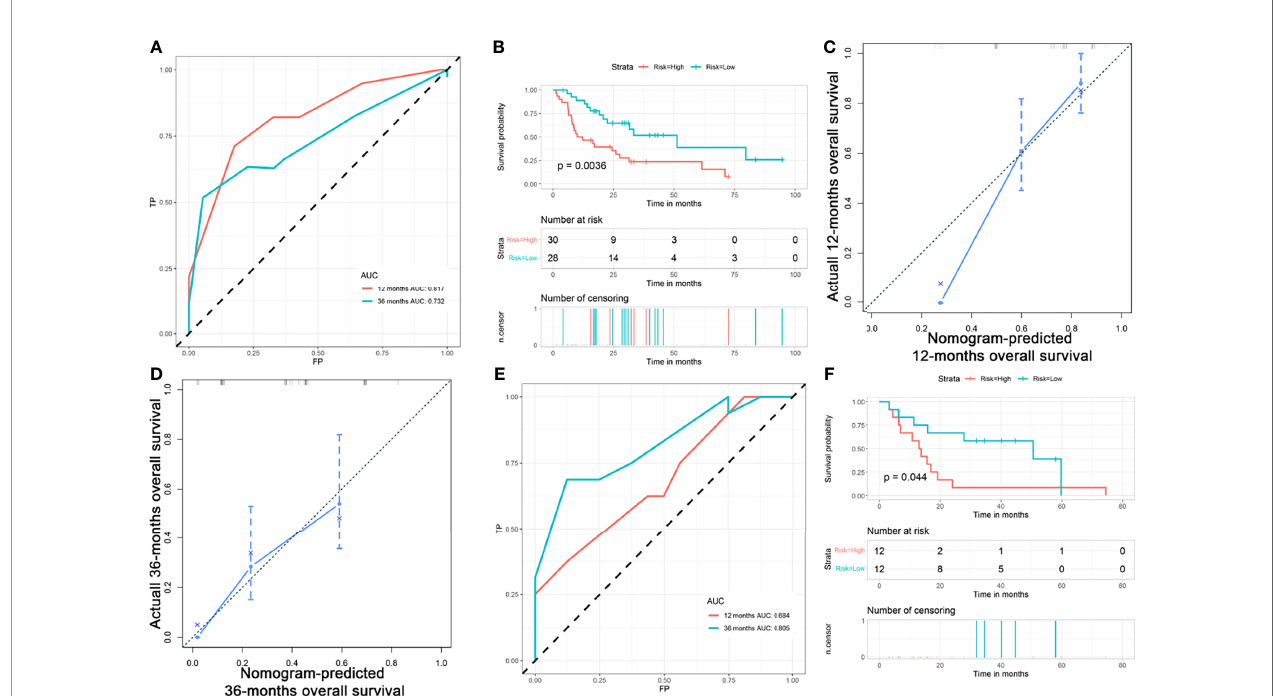
FIGURE 3 | Validation of radiomics model in mass forming ICC patients. (A) AUC of radiomics model in the training cohort; (B) OS of patients with ICC in training cohort; (C) Calibration curve for predicting 1 -year survival in training cohort; (D) Calibration curve for predicting 3 -year survival in training cohort; (E) AUC of radiomics model in the validation cohort; (F) OS of patients with ICC in validation cohort by risk strati fi